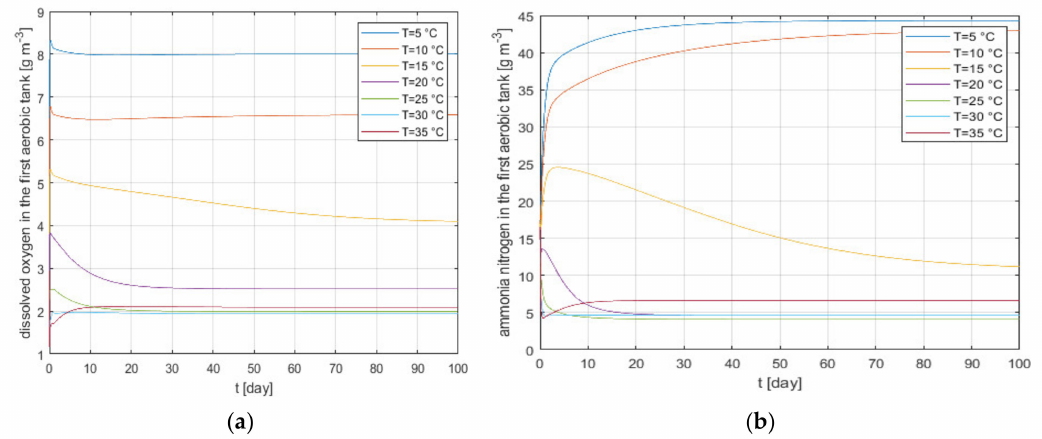
Figure 10. Carbonaceous substrate ( a ) and heterotrophs ( b ) in the first aerobic tank for di ff erent temperature values.